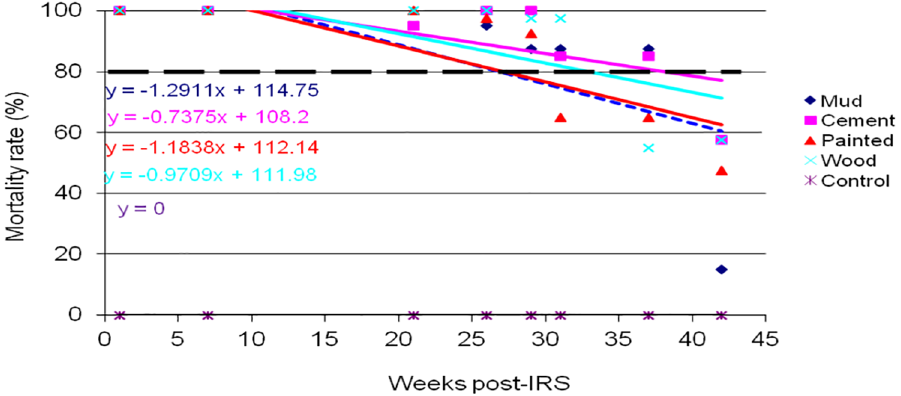
Fig 4. Cone wall bioassay response of susceptible strain An . gambiae s . s to p-methyl 300 CS sprayed in different wall surfacesin Ochuna village, Rorya district. The dashed line representsthe WHO threshold of 80%